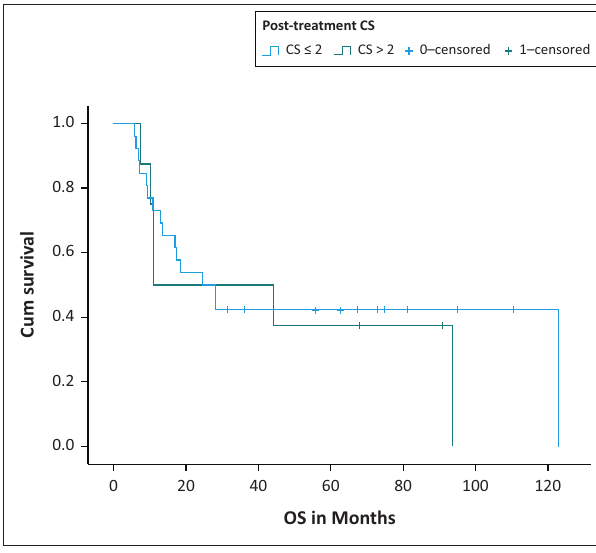
CS, Curie score; OS, overall survival. FIGURE 2: Overall survival compared with the end of treatment Curie score for scores ≤ 2 versus >